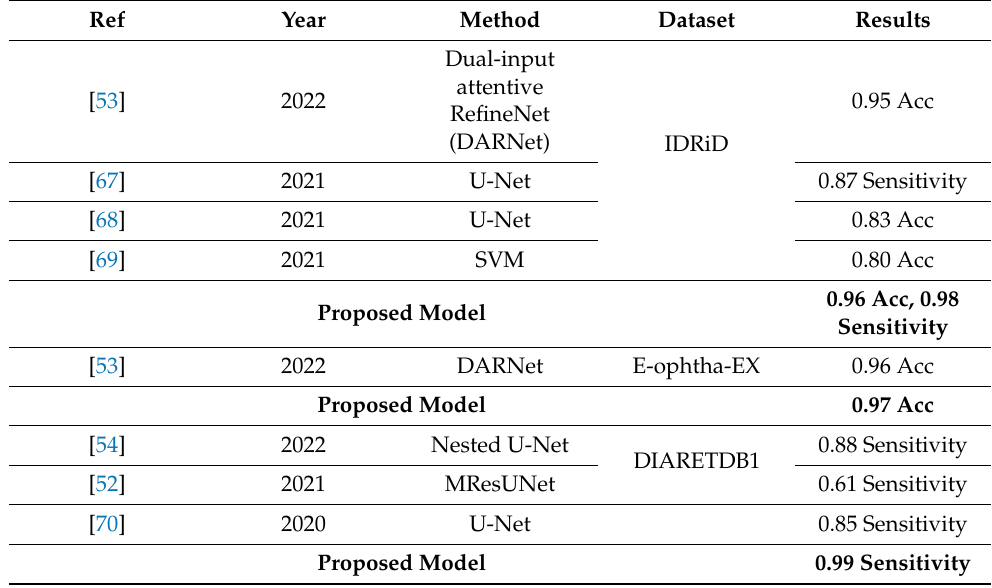
Table 6. Comparison of segmentation results.